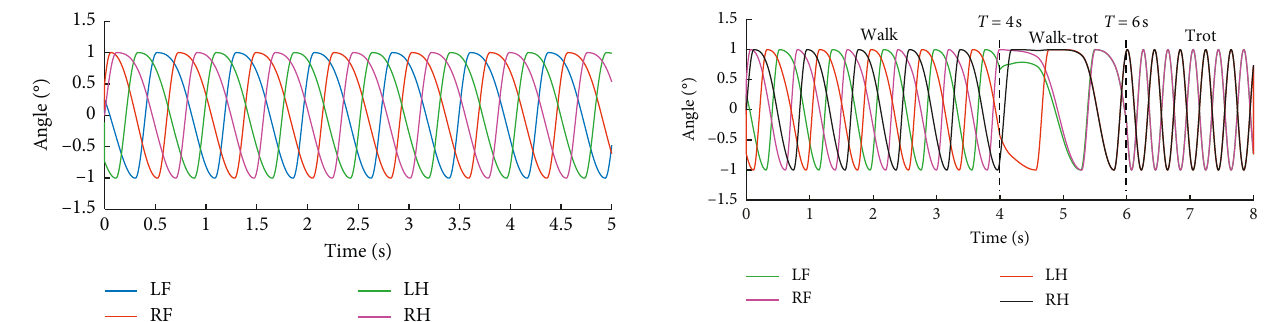
Figure 12: Gait conversion by replacing the gait matrix.